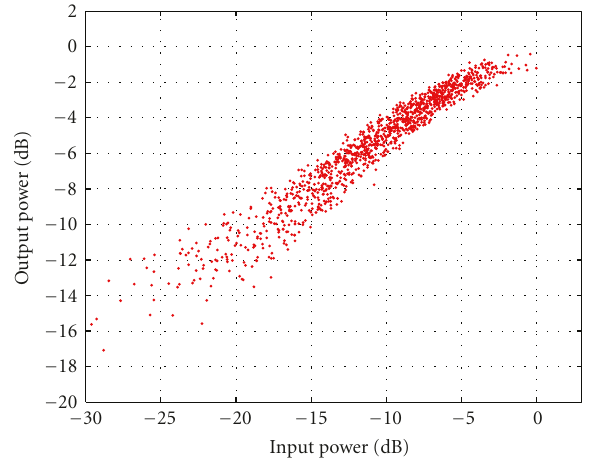
Figure 7: AM/AM characteristic.